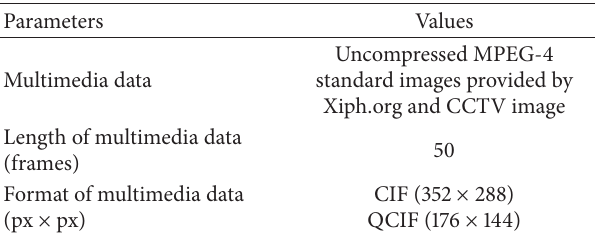
Table 1: Simulation parameters.